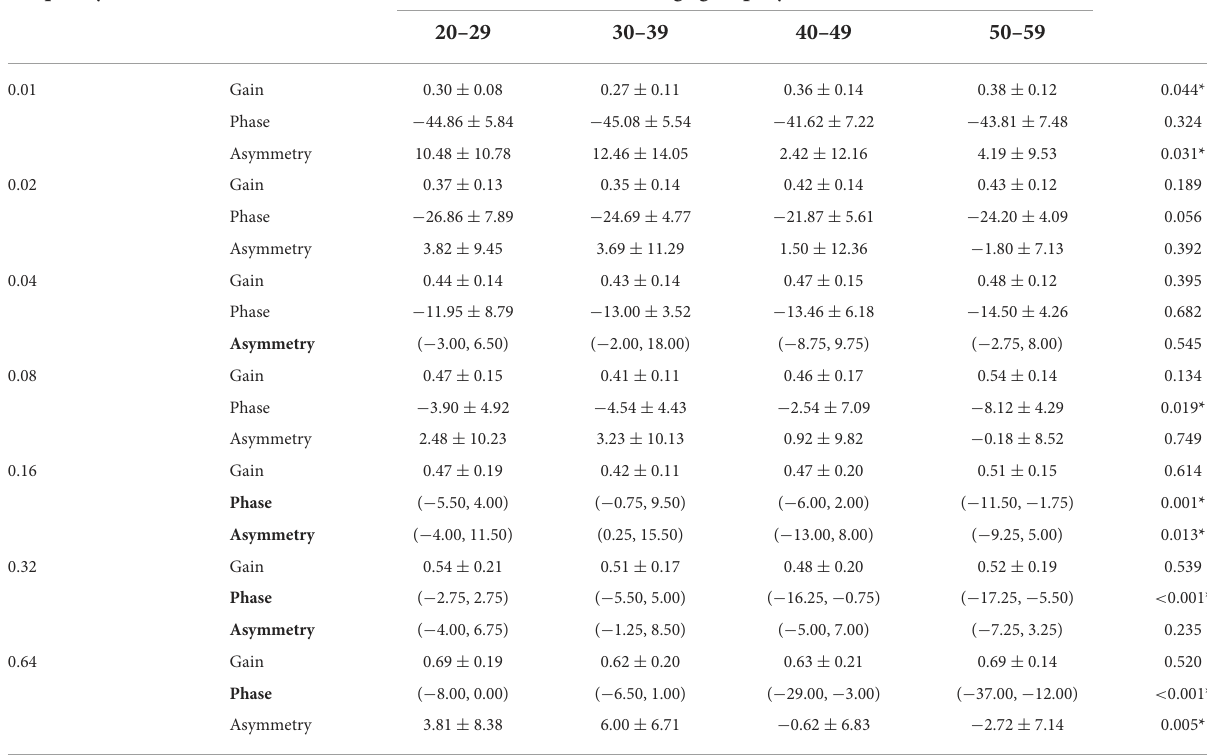
TABLE 3 SHAT normative values of four age groups.